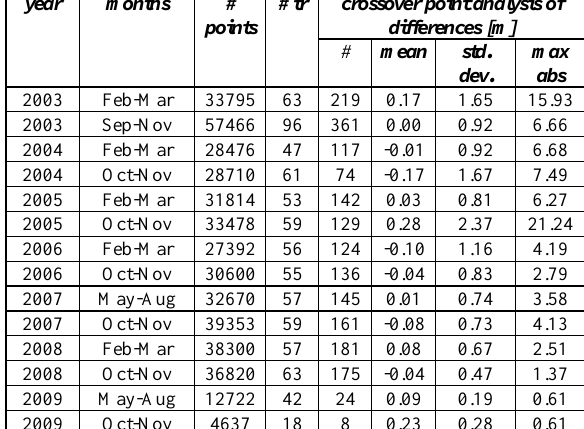
Table 1. Characteristics of different campaigns of GLAS